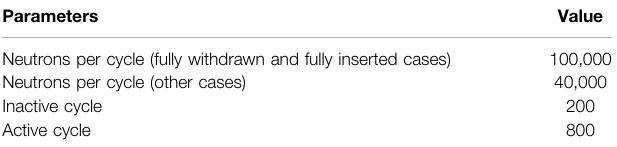
TABLE 3 | Calculation parameters of control rod worth.